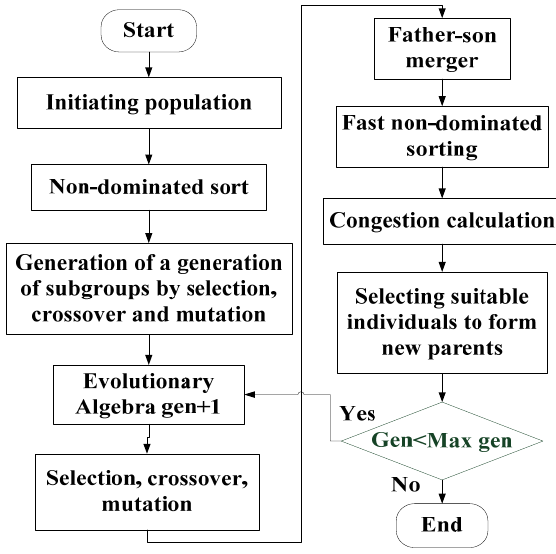
Figure 5. NSGA ‐ II algorithm flow chart. Figure 5. NSGA-II algorithm flow chart.